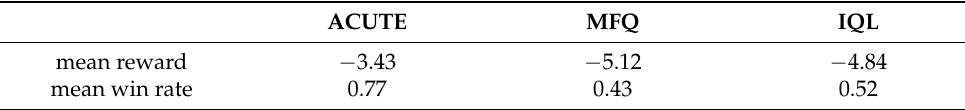
Table 2. Mean reward and win-rate per episode on ma-gym: